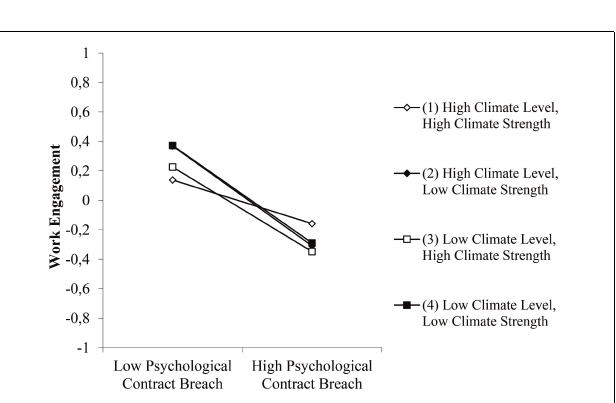
FIGURE 2 | The interaction between PCB and commitment climate strength in relation to work engagement.